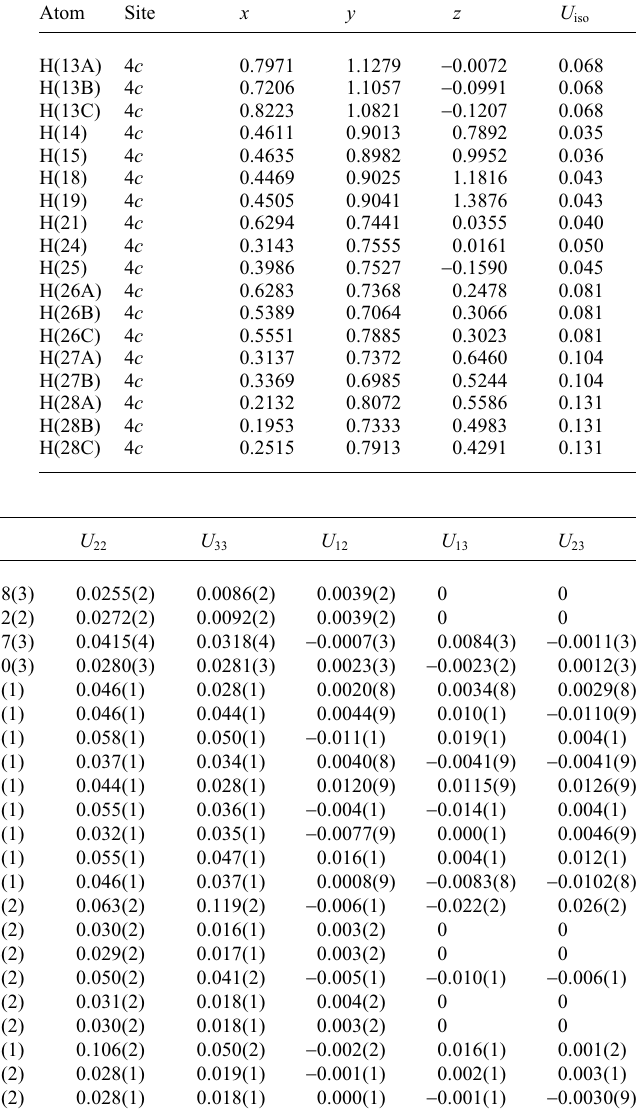
Table 2. Atomic coordinates and displacement parameters (in Å 2 )